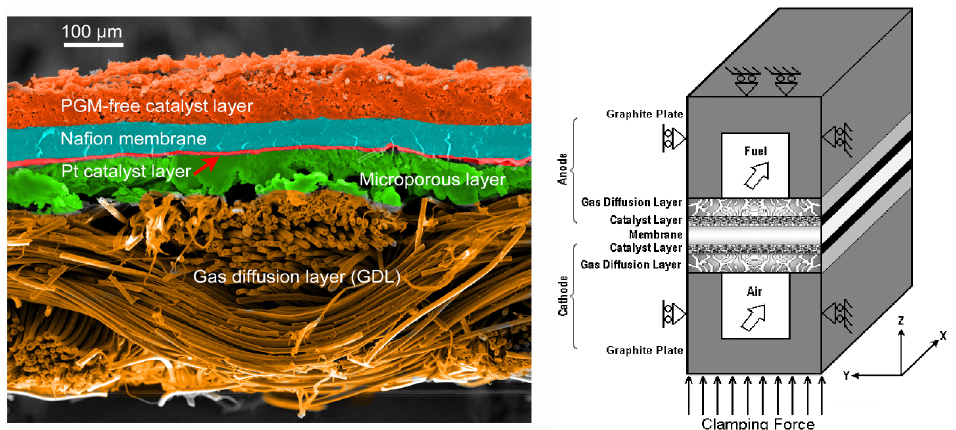
Fig. 14. – Left: Scanning Electron Microscopy (SEM) micrograph of a PEMFC MEA (see also [57]). Source: Wikimedia ( commons.wikimedia.org/wiki/File:SEM micrograph of